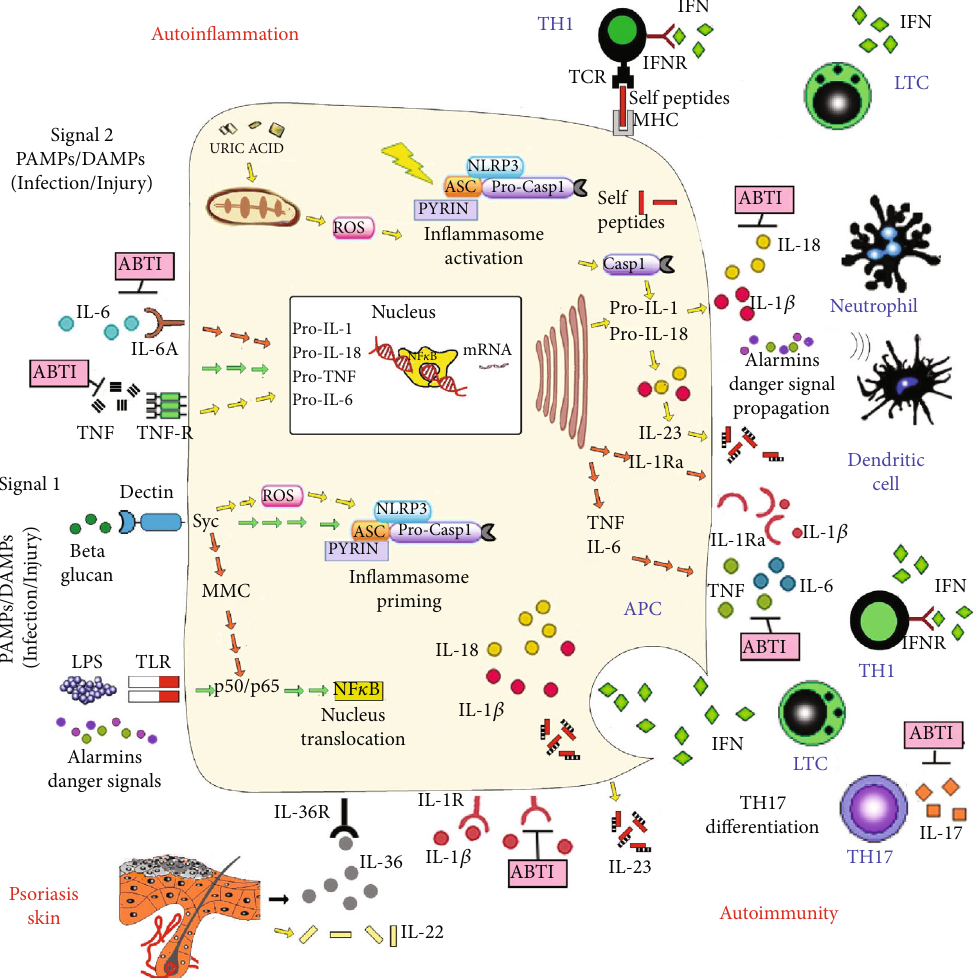
Figure 3: Schematic representation of in fl ammasome signaling mechanisms in mixed-pattern in fl ammatory diseases. In fl ammatory agents and pathogens trigger the canonical in fl ammasome pathway. PAMPs and DAMPs are detected by speci fi c innate immune sensors, leading to oligomerization and in fl ammasome assembly. The therapeutic targets in autoin fl ammatory diseases are as follows: signal 1 in fl ammasome activation: surface pattern recognition receptors like Toll-like receptors (TLR) and pathogen-associated molecular patterns stimulate the production of molecules like NF- κ B and activate in fl ammasome assembly through downstream immunologic processes; signal 2 in fl ammasome activation: crystals in gout, heat-shock proteins, and damaged tissue as in burns, another pathogen- and damage- associated molecular pattern, activate in fl ammasome assembly through reactive oxygen species (ROS) production and